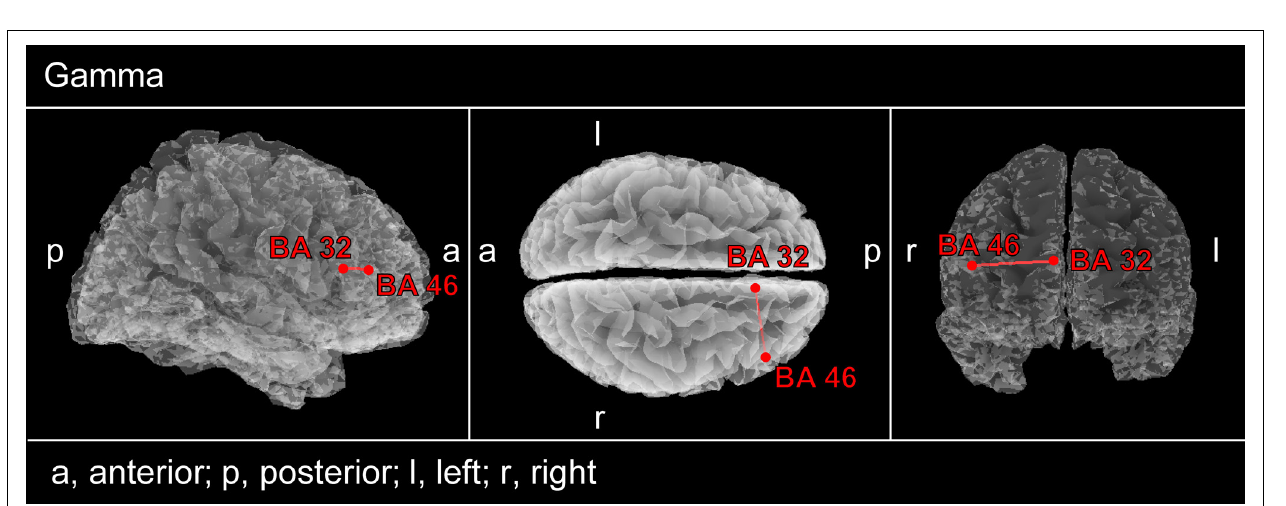
FIGURE 5 | Connectivity contrast analysis between PC and NPC patients. rmANOVA analysis was applied to those brain areas which showed differential effects of CR therapy depending on whether or not tinnitus pitch changed strongly (see Figure 3 ). Decreased gamma lagged linear connectivity can be seen in PC patients between right ACC (BA 32) and DLPFC (BA